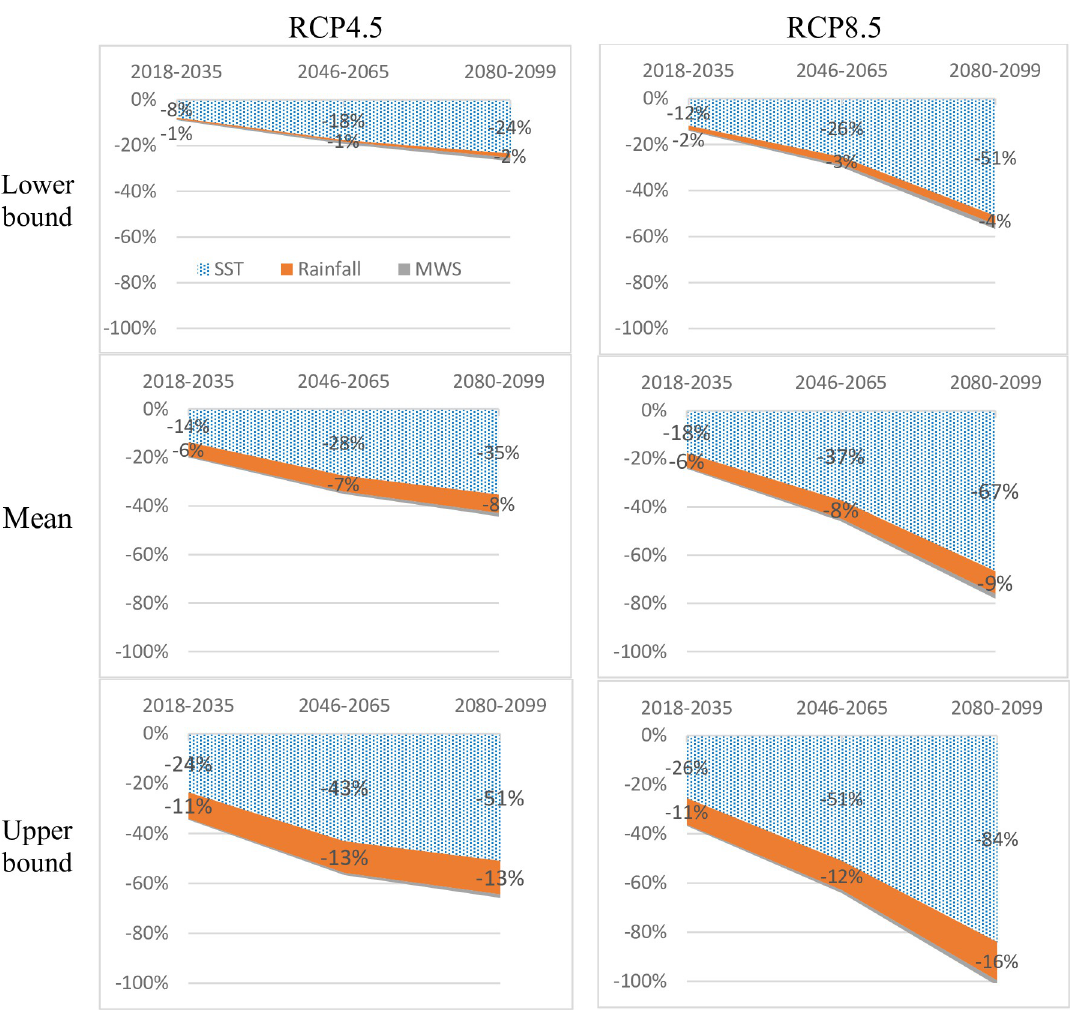
Fig 2. Potential decrease in capture yield in early, mid and end of the 21 st century by climate change scenarios RCP4.5 and RCP8.5 relative to